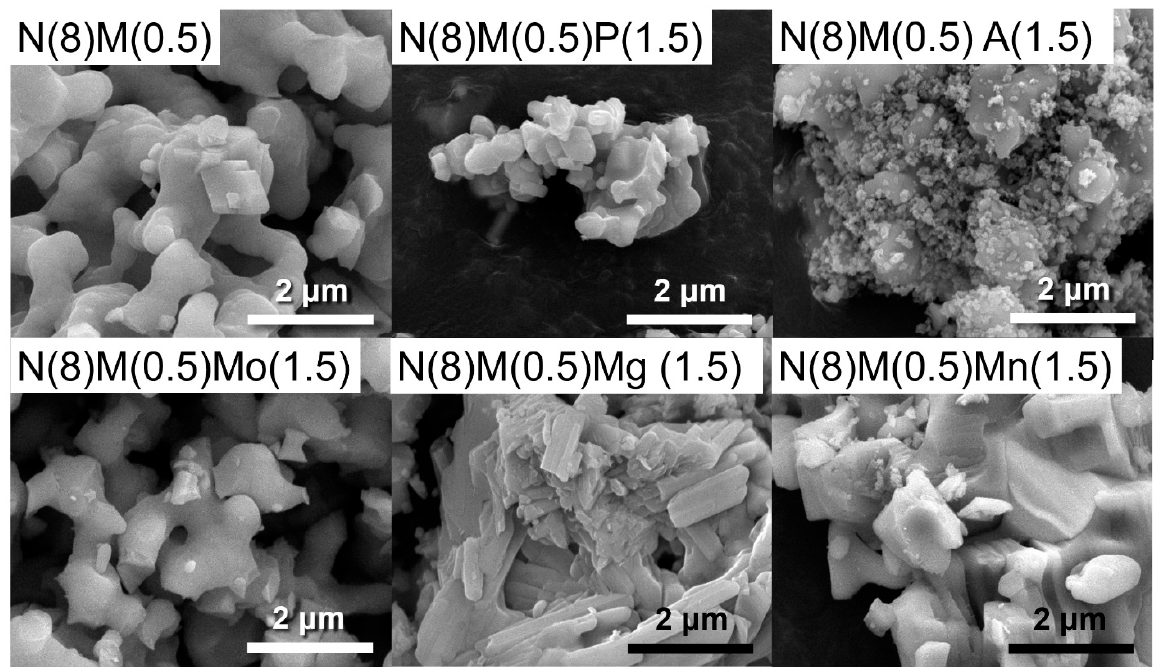
Figure 1. SEM images of the catalyst pellets prepared using an organic binder MC and different inorganic binders.